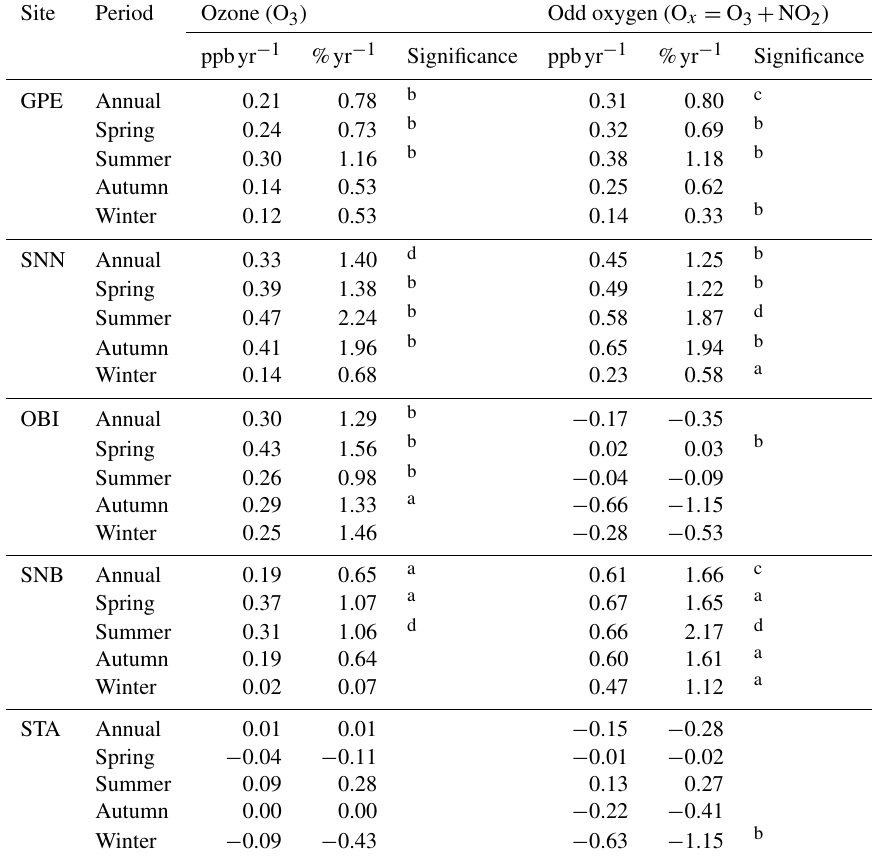
Table 3. Results for O 3 and O x long-term trends expressed in ppb yr − 1 for 1993–2014 at the five sites within the MMA by